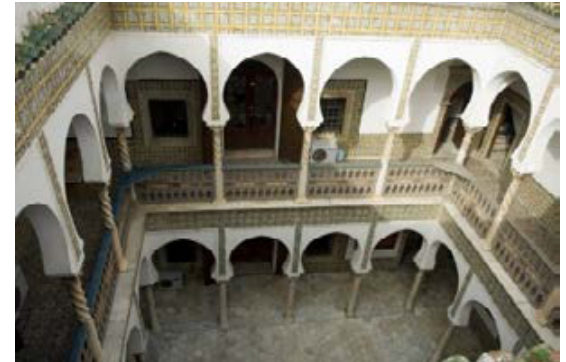
Figure 2. Four arched gallery